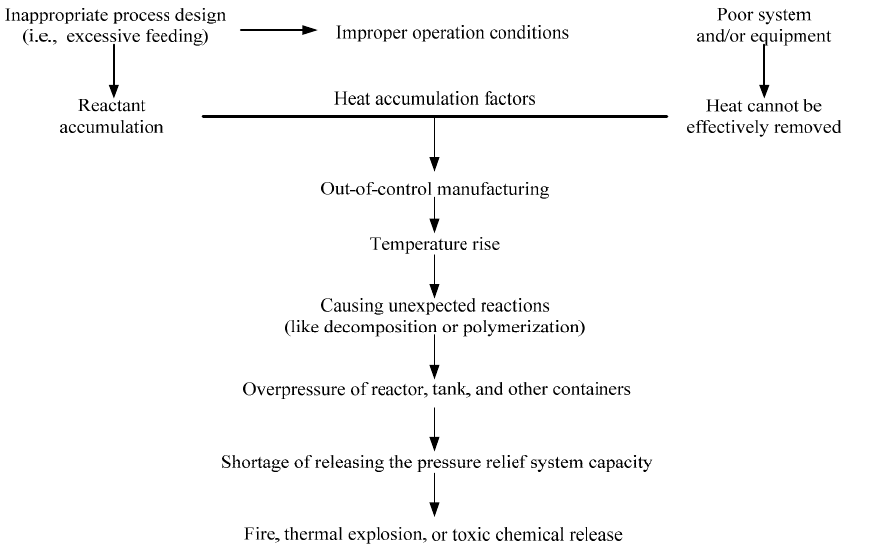
Figure 1. Illustration of a process leading to an out-of-control reaction.